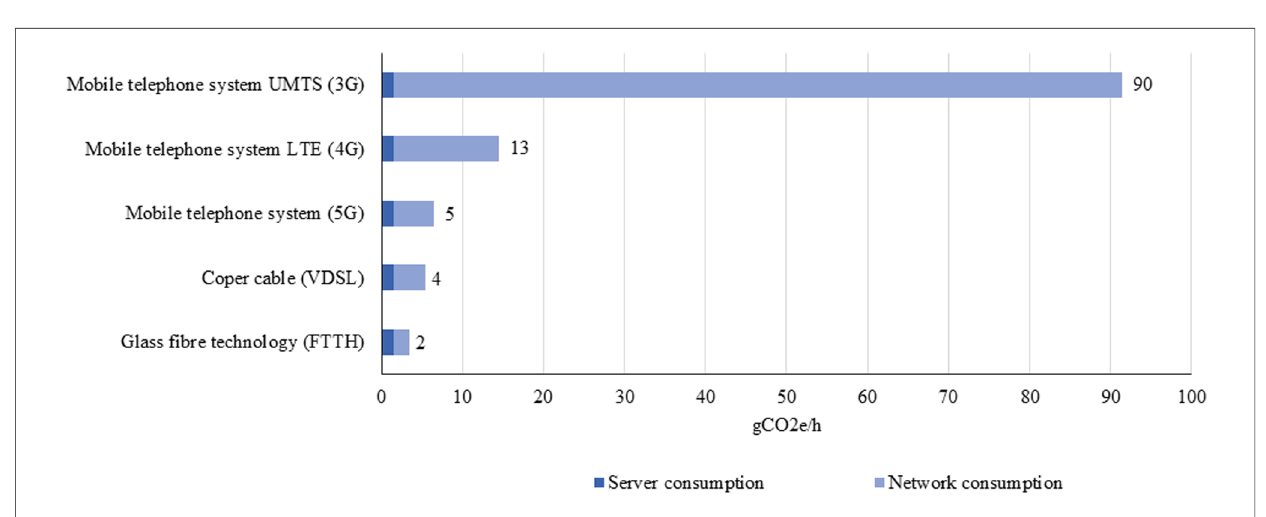
FIGURE 2 Co 2 e emission of data centre and network usage compiled after German federal environment agency (UBA)